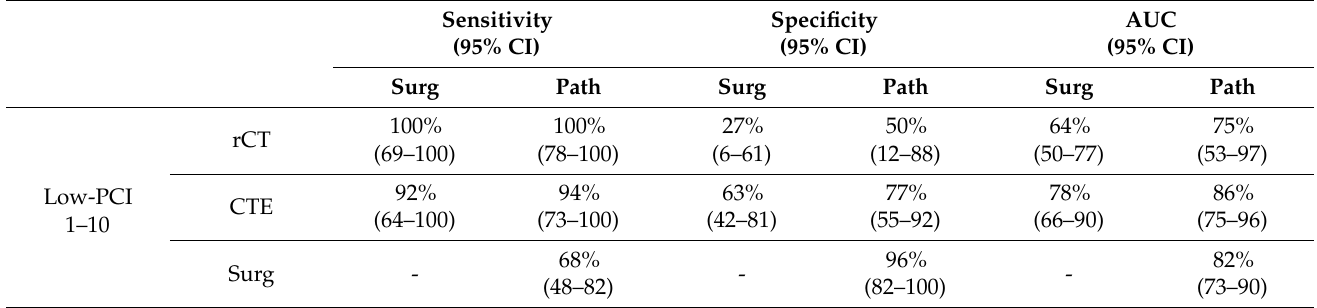
Table 6. Comparative diagnostic performance between the PCI measurements tools according to the tumor burden (Low-PCI, Mod-PCI, High-PCI) and compared with surgical and pathological reference